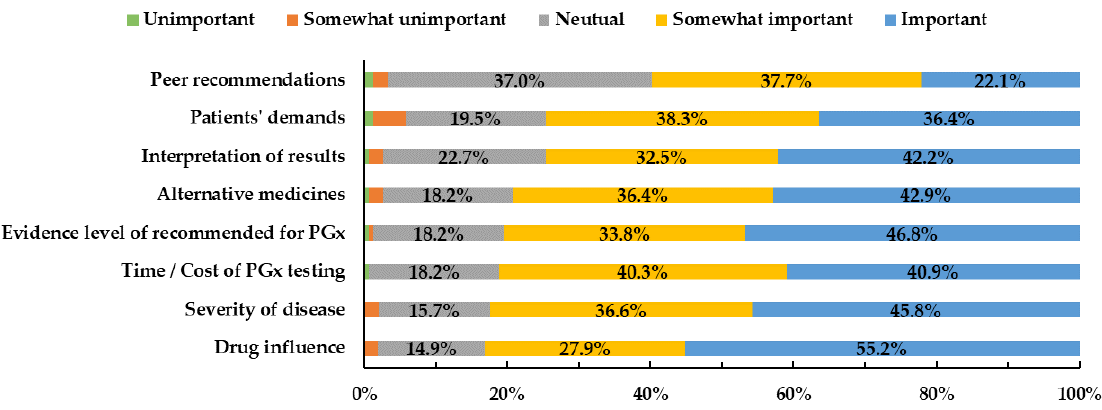
Figure 4. Factors contributing to p hysicians’ PGx